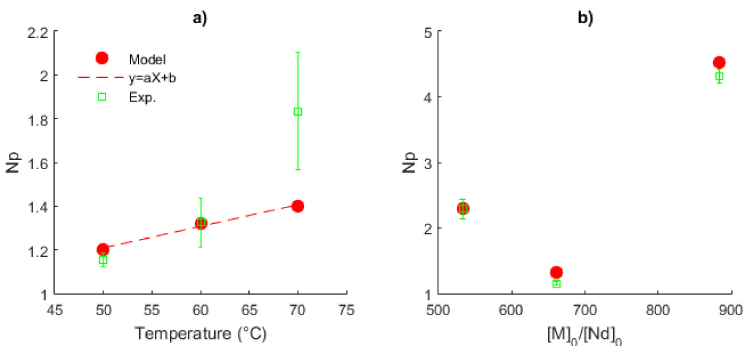
Figure 14. Plots of the number of polymer chains produced by the neodymium atom, Np. ( a ) Effect of the temperature, Exps. 1–3, [ M ] 0 /[ Nd ] 0 = 660. ( b ) Effect of the ratio [ M ] 0 /[ Nd ] 0 , Exps. 2, 4 and 5 at 60 ◦